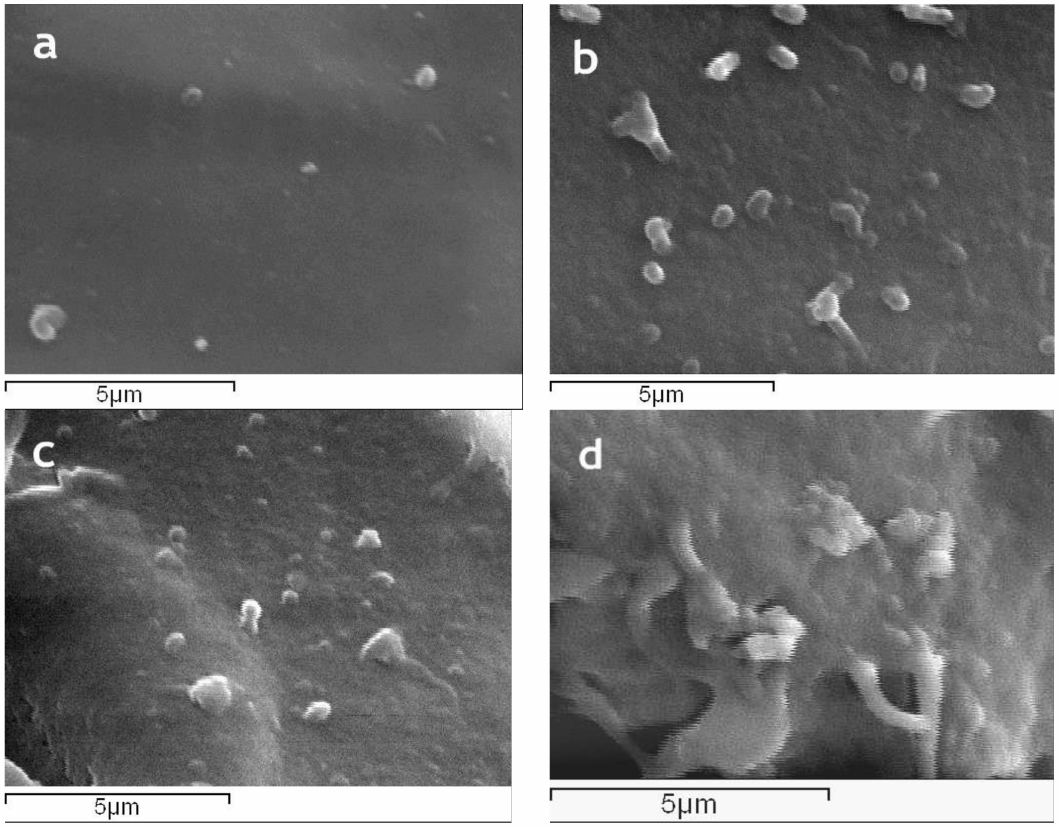
Figure 5. SEM images of SFm nanoparticles ( a ); SFm + propranolol NPs ( b ); SF-BSA-NPs ( c ); and SF-BSA + propranolol NPs ( d